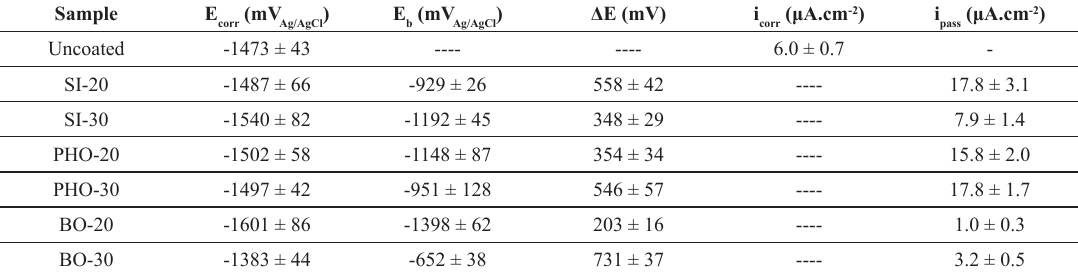
Table 4. Electrochemical parameters of the uncoated and anodized AZ61 alloy obtained from the potentiodynamic polarization curves shown in Figure 11. Sample